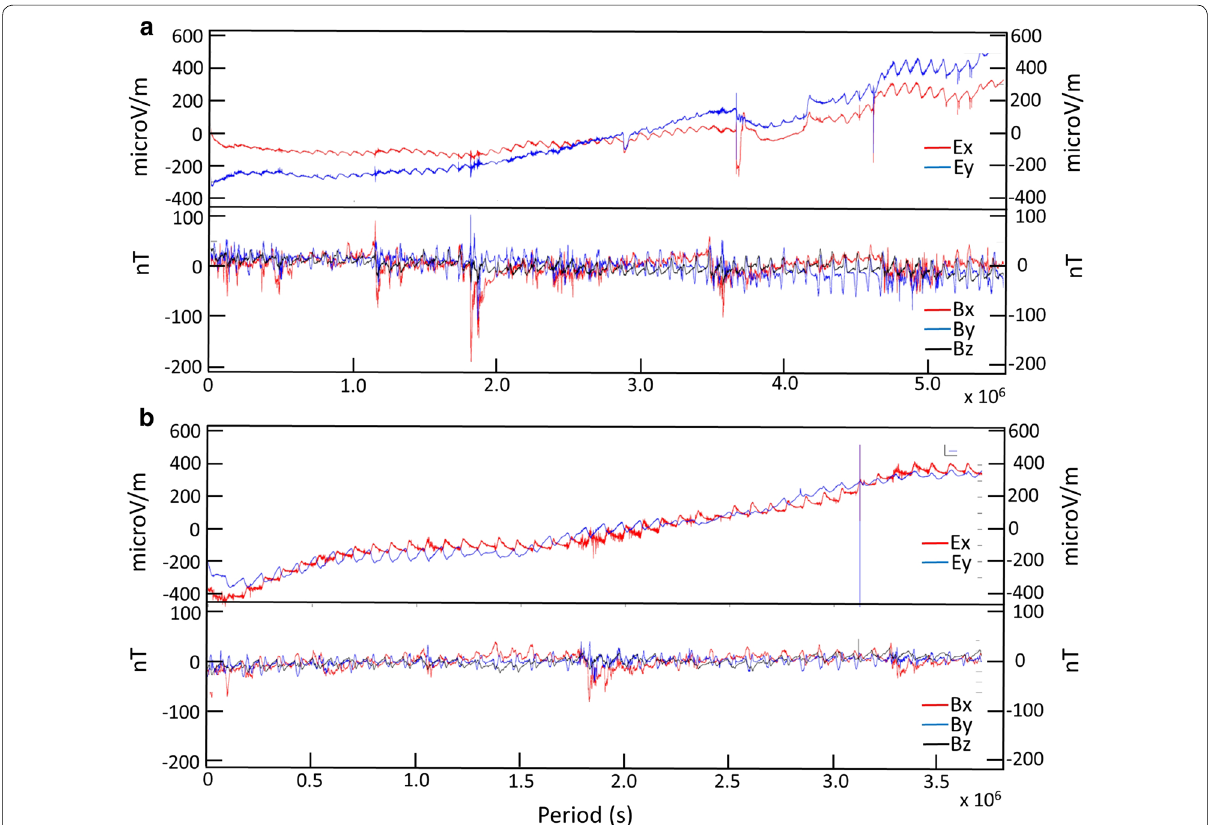
Fig. 4 Concatenated MT time series for a site SA275 and b site SA294. These time series plots illustrate the data quality recorded. The plots show strong diurnal signal variation as well as several periods of strong geomagnetic